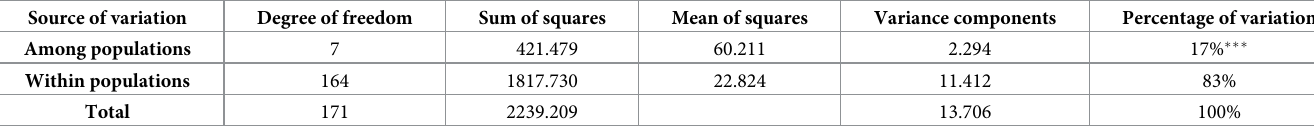
Huocheng. Table 3. Analysis of molecular variance (AMOVA) for P . armeniaca var. ansu populations. Source of variation Degree of freedom Sum of squares Mean of squares Within populations Total